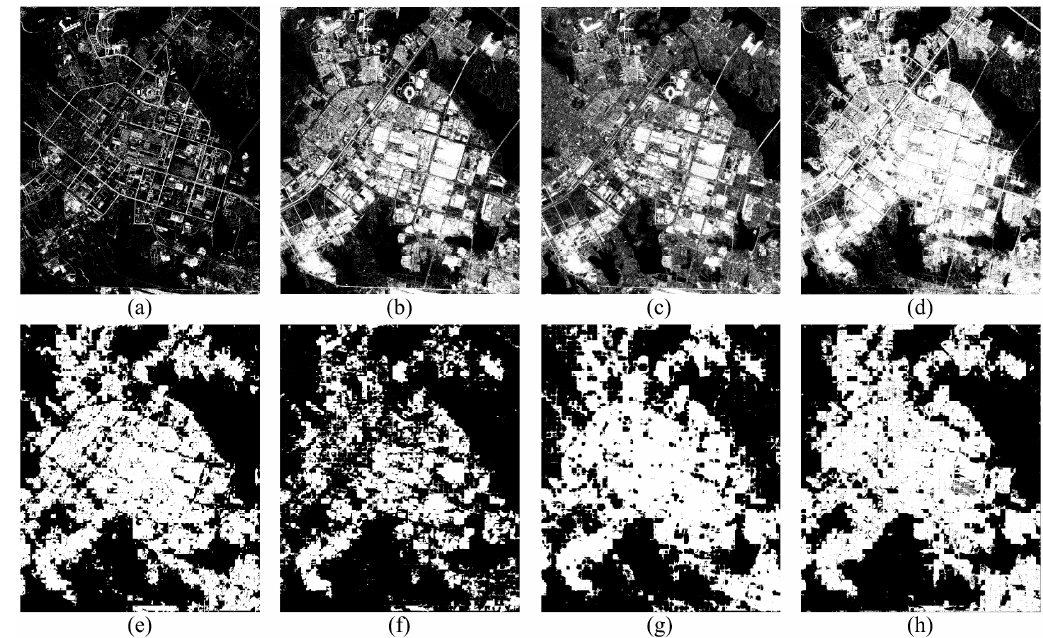
Figure 10. Binary change maps (Experiment 2) obtained by the ( a ) RCVA, ( b ) SVM, ( c ) RF, ( d ) DBN, ( e )U-Net, ( f ) SegNet, ( g ) DeepLabv3+, ( h ) Proposed method.